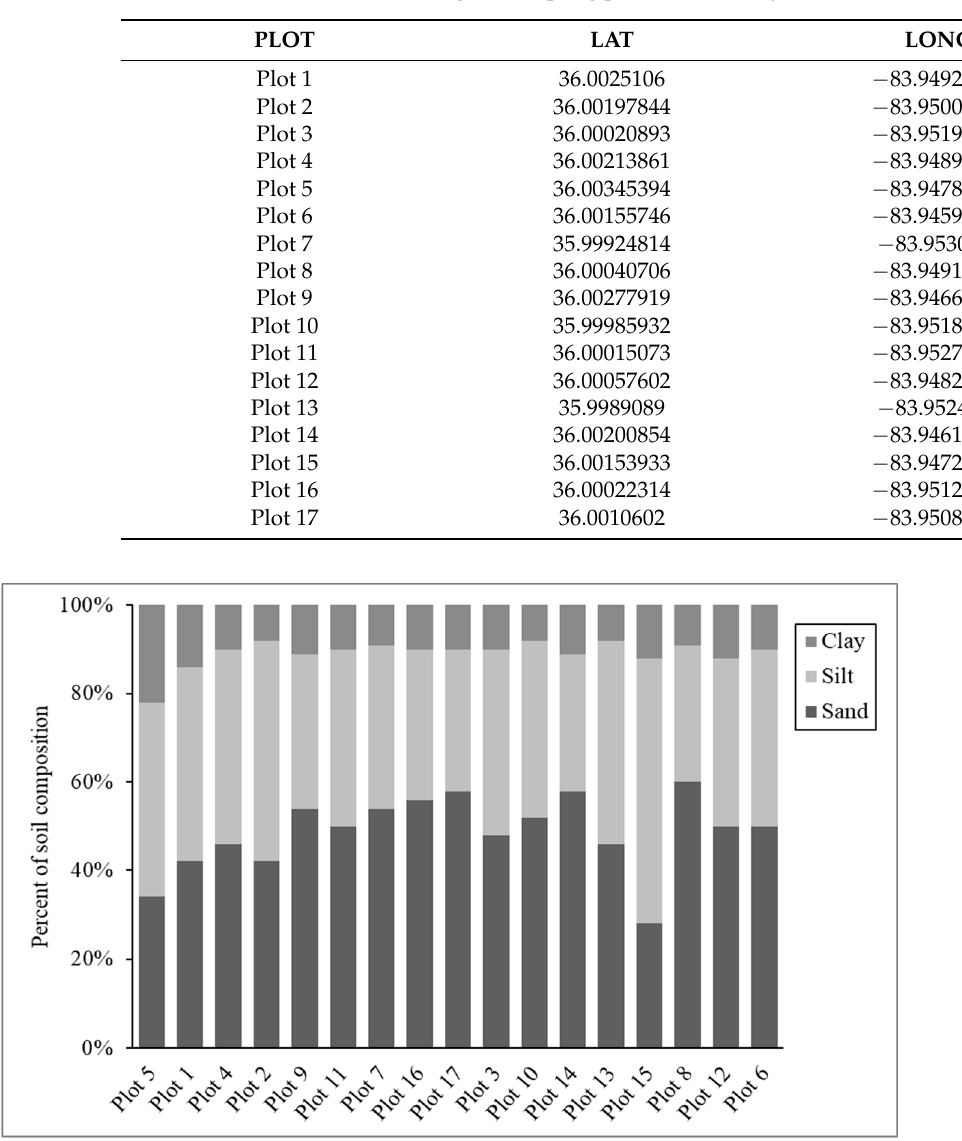
Figure A2. Soil texture across all plots by increasing elevation ( n = 17). Table A3. Soil volumetric water content, bulk density, and texture analyses and relationships to plot aspect, average slope, and plant root growth.